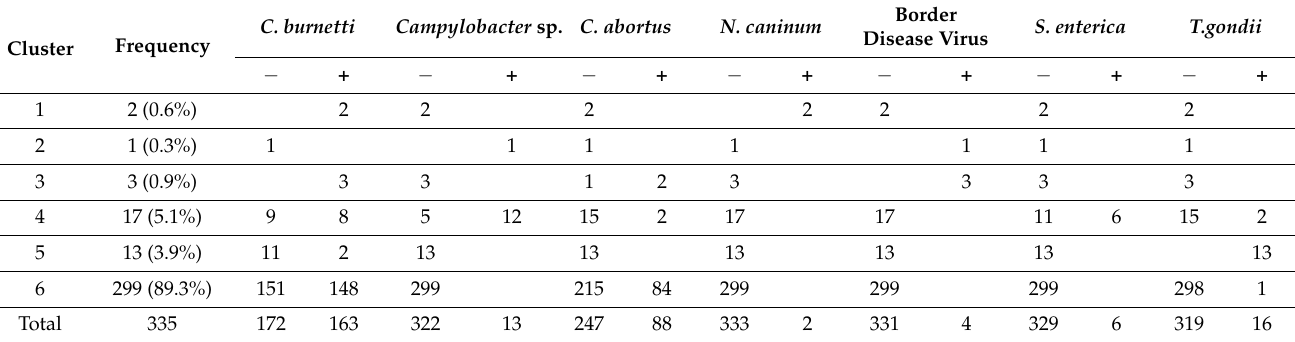
Table 7. Characteristics of samples from 335 caprine abortions included in the six clusters obtained in the study. Absence or presence of a particular pathogen was recorded as 0 and 1, respectively.